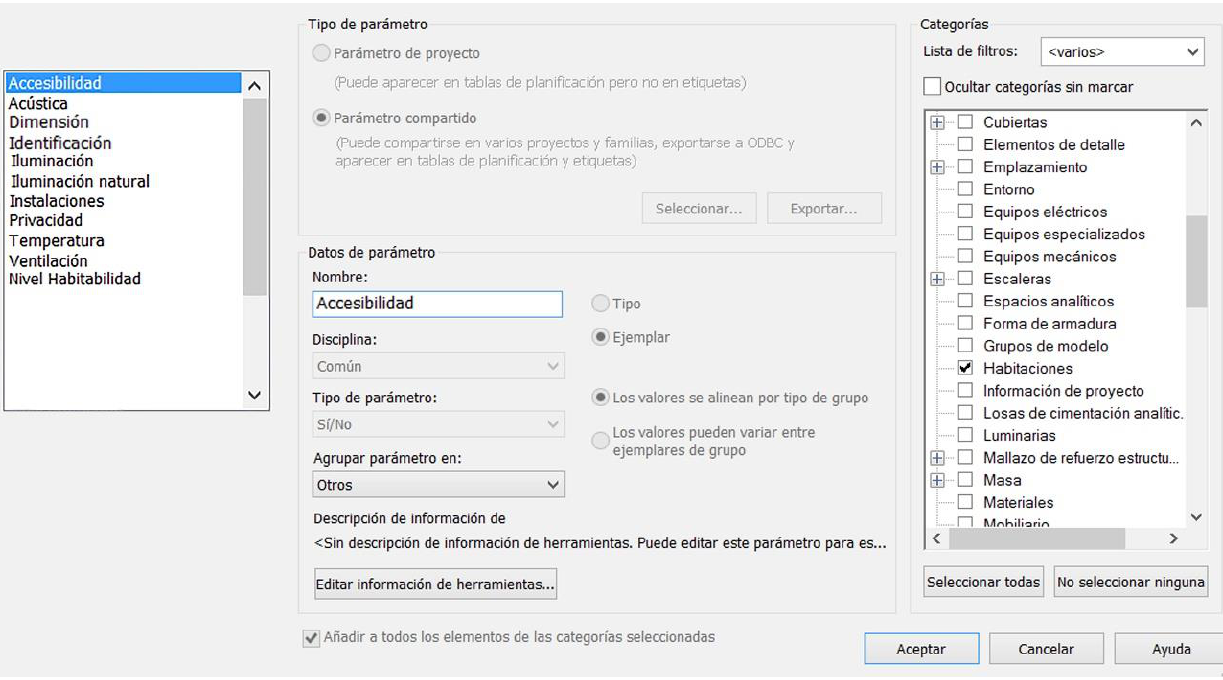
Figure 9. Habitability parameters, 2021.